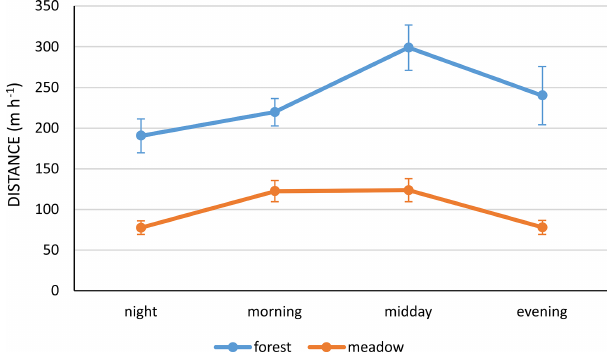
Figure 4. The mean distance (mh − 1 ) travelled by Polish Konik horses during different times of the day in both